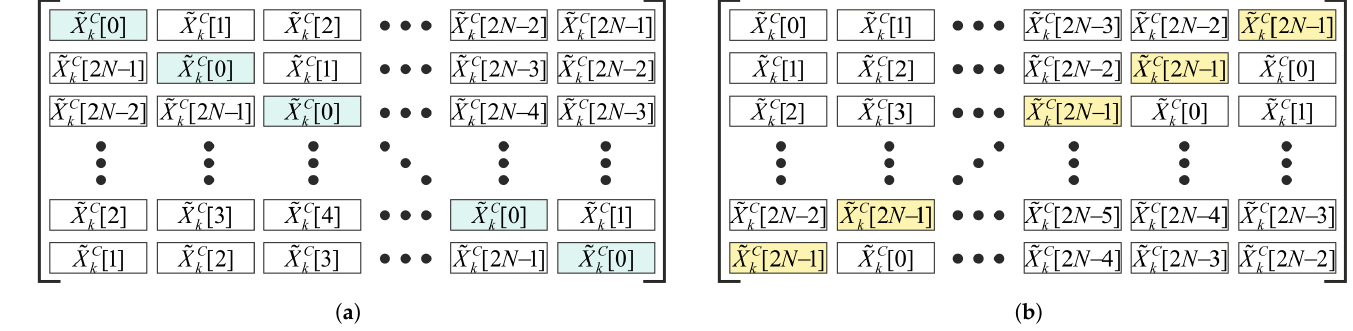
Figure 3. The structures of the matrices: ( a ) circulant matrix XR ( k ) and ( b ) anticirculant matrix XL ( k )